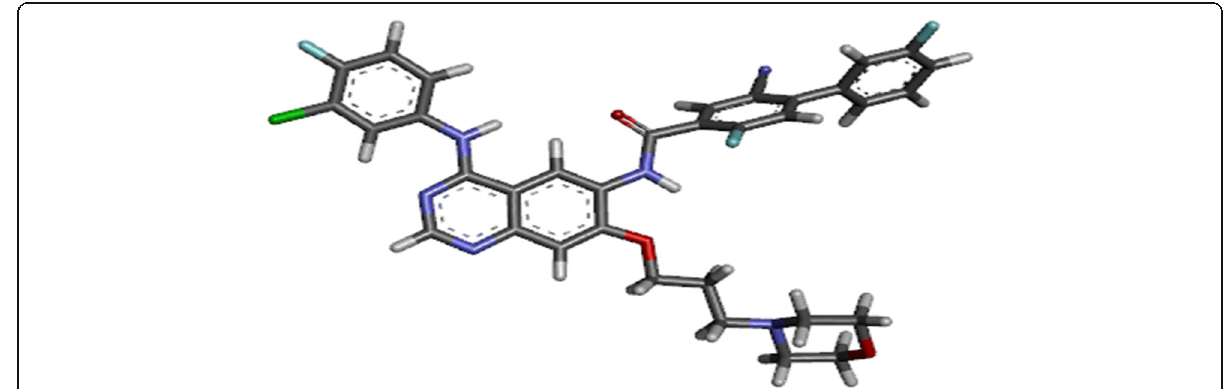
Fig. 3 The 3D optimum conformation of a prepared designed EGFR